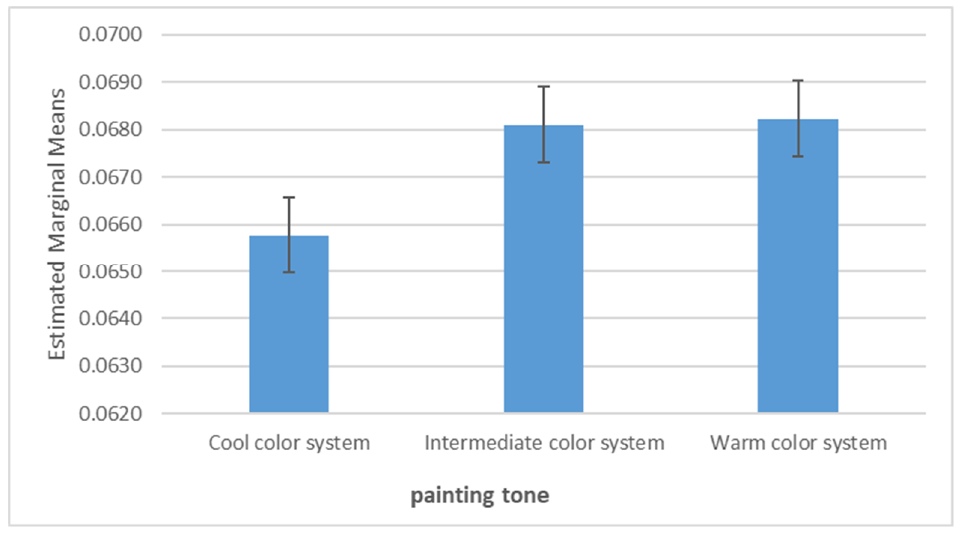
Figure 8. The influence of the tone of the painting on the coefficient of variation for pupil diameter.